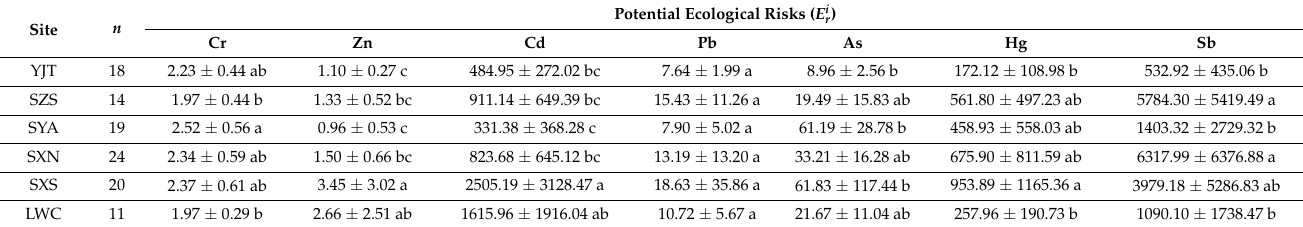
Table 3. Assessment of potential ecological risks of soil PTEs from the six sampling sites.